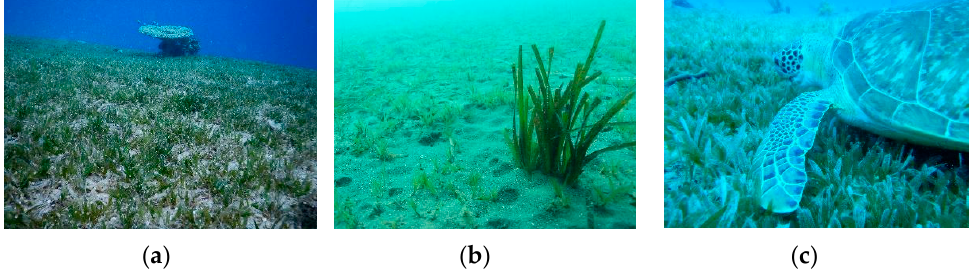
Figure 1. ( a ) Meadow of native Halophila stipulacea in the Red Sea, ( b ) shoots of invasive H. stipulacea in the eastern Mediterranean Sea mixed with shoots of the endemic Posidonia oceanica and ( c ) meadow of invasive H. stipulacea in the Caribbean Sea with the green sea turtle ( Chelonya mydas ) feeding on it. Pictures ( a , c ) by Gidon Winters, picture ( b ) by the ©Marine and Environmental Research (MER) Lab. (Limassol, Cyprus).